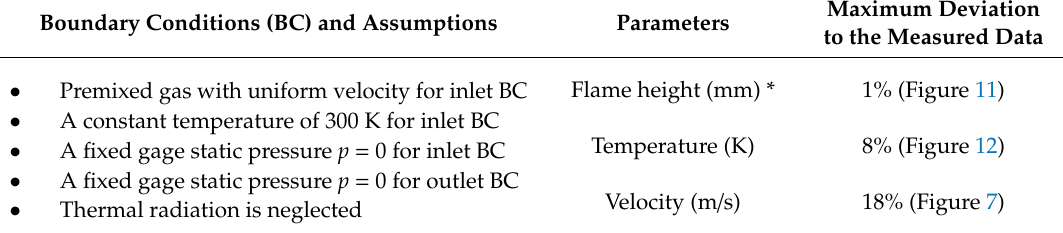
Table 2. The error analysis for simulation boundary conditions and